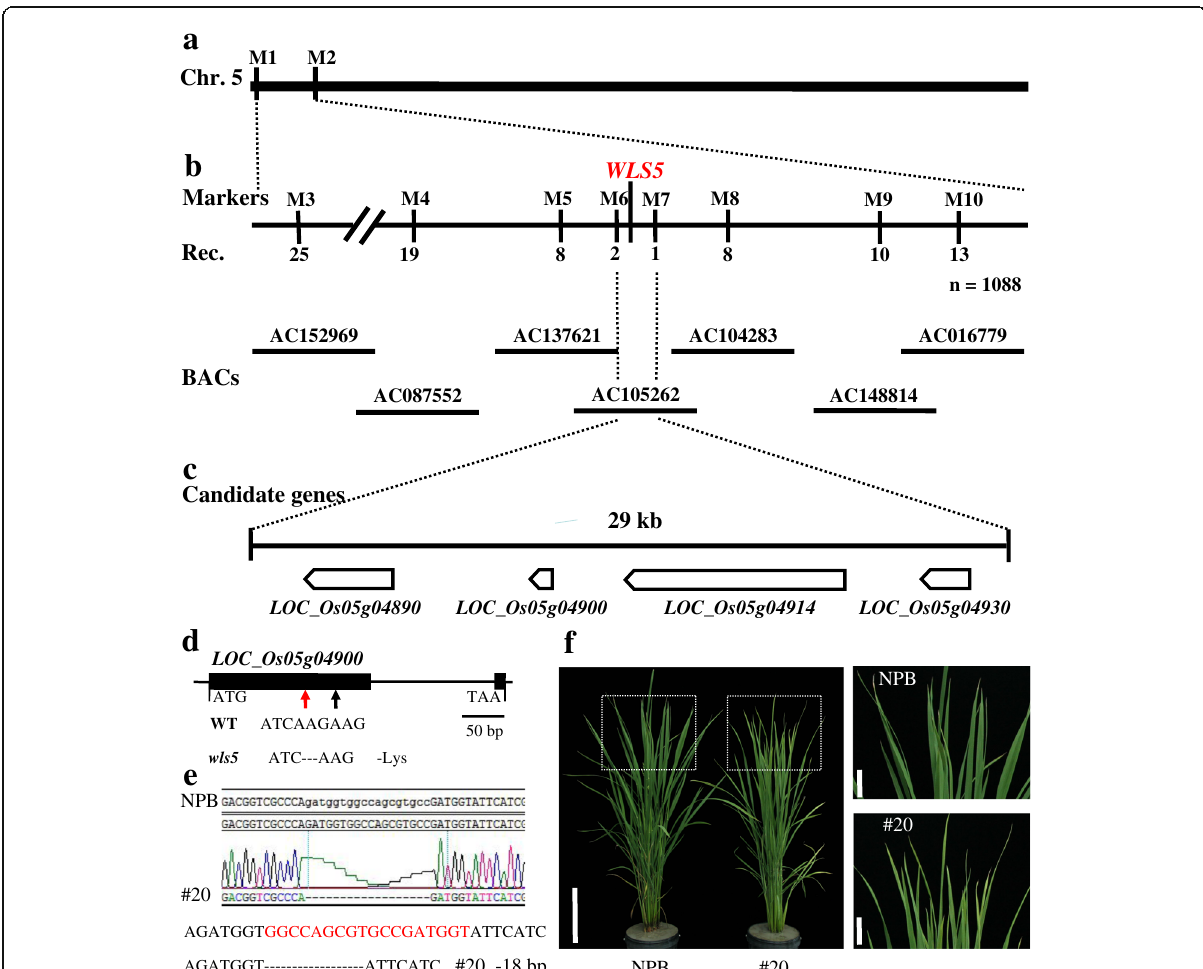
Fig. 9 Candidate gene analysis for WLS5 . a Location of WLS5 on rice chromosome 5. b Coarse linkage map of WLS5 . Markers used for mapping are indicated. Numbers below lines indicate number of recombinants. c Candidate genes for WLS5 . d LOC_Os05g04900 structure and sequence variations between wild type and wls5 . Black and red arrows indicate mutation site and target knockout position, respectively. e , f LOC_Os05g04900 knockout in ‘ Nipponbare ’ (NPB). CRISPR/Cas9-induced 18-bp deletion in LOC_Os05g04900 ( e ). Phenotype of NPB and line #20. Bars=25cm (left) and 12.5cm (right) ( f